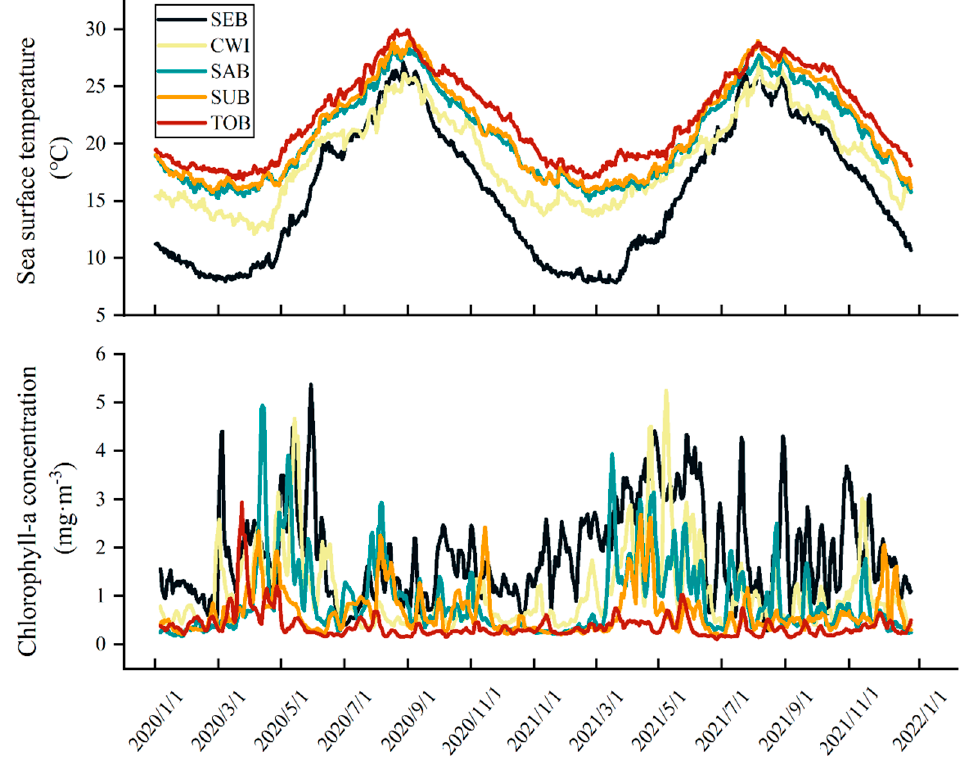
Figure 2. Daily sea surface temperature (upper) and five-day moving averaged chlorophyll-a concentration (lower) averaged over the broader sampling areas in 2020–2021.